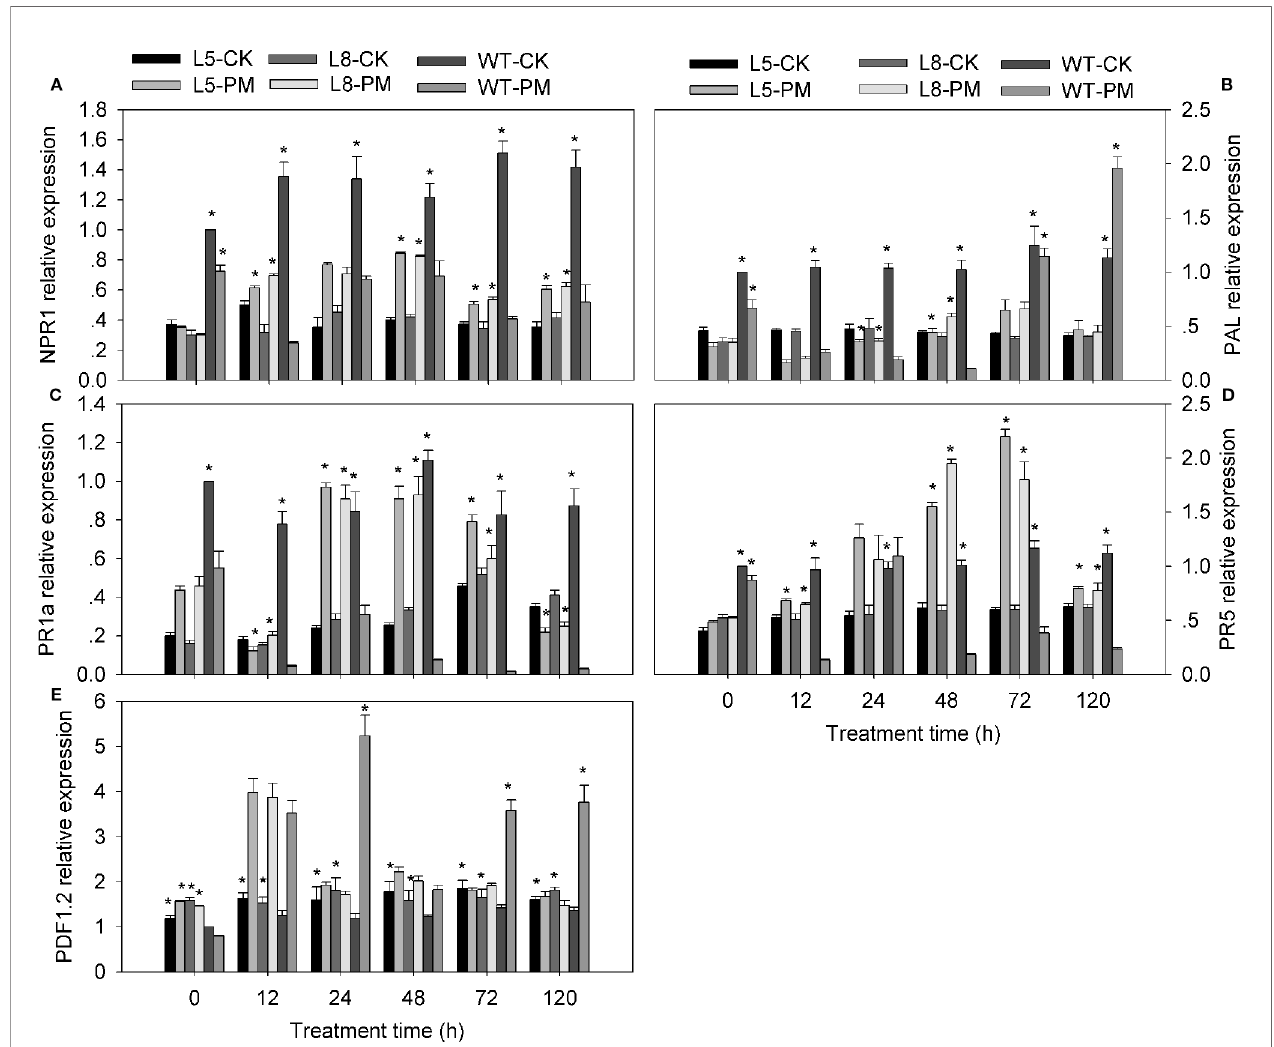
FIGURE 5 | Expression of signal-related genes in transgenic and wild-type (WT) plants treated with powdery mildew. The samples of two genetically-modi fi ed tobacco lines (L5, L8) were used to analyze genes expression by qRT-PCR. A, NtNPR1 ; B, NtPAL ; C, NtPR1a ; D, NtPR5 ; E, NtPDF1.2 . There were four treatments: L5/L8-CK represents transgenic lines under normal conditions; L5/L8-PM represents transgenic lines infected with powdery mildew; WT-CK represents WT plants under normal conditions; WT-PM represents WT plants infected with powdery mildew. Tobacco NtEF1- a gene (AF120093) was used as an internal reference. The expression levels of signal-related genes in WT plants at 0 h were used as control (quantities of calibrator) and assumed as 1. Three biological triplicates per line were averaged and Bars indicate standard error of the mean. Data between transgenic lines and WT plants (L5/L8-PM vs. WT-PM and L5/L8-CK vs. WT-CK) were analyzed by one-way ANOVA, and *denotes statistical signi fi cance at p <